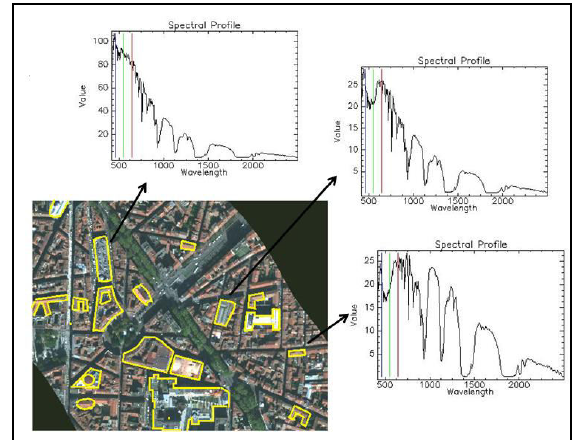
Figure 9. Classification of building types regarding their morphometric and spectral